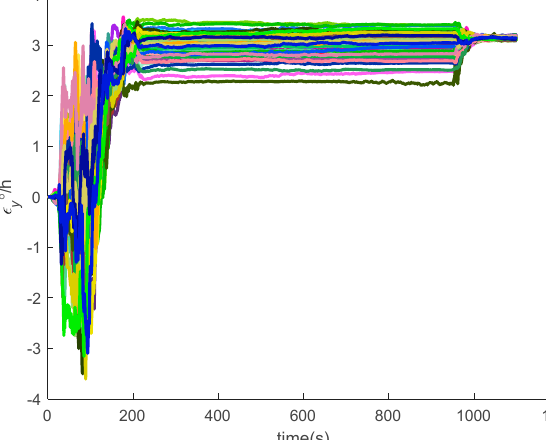
Figure 26. The y -axis gyroscope constant drift of SINS/GPS in the LCEF frame.